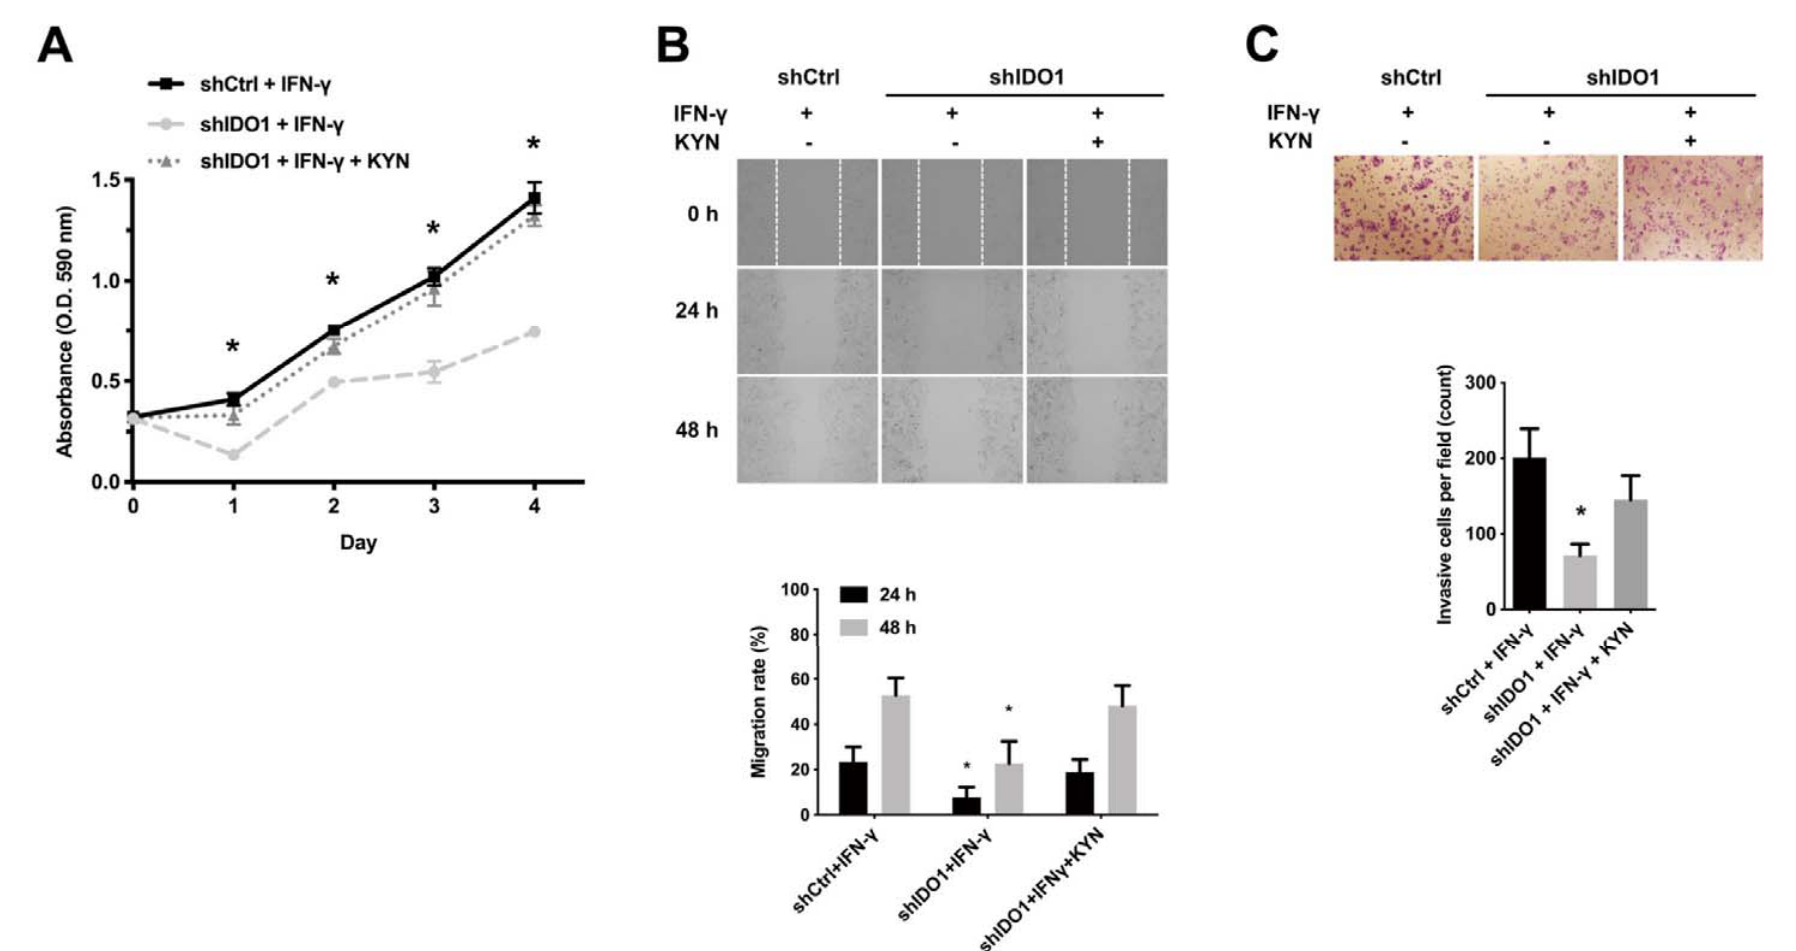
Figure 2. Upregulation of IDO1 activity promotes proliferation, migration and invasion of HCC cells. ( A ) Promotion of HCC cell proliferation is IDO1 activity-dependent. Knockdown of IDO1 significantly suppressed the proliferation of shIDO1 cells compared to shCtrl cells, while KYN recued the growth of shIDO1 counterparts. Viability of IDO1 knockdown and control HuH-7 cells under IFN- γ (40 ng/mL) treatment with or without KYN (100 μ M) rescue monitored for four days via MTT assay. Plots depict cumulative absorbance versus number of days. ( B ) Knockdown of IDO1 significantly inhibited the migration of shIDO1 cells compared to the shCtrl cells. The lost migratory ability was rescued by KYN. Wound healing assay of